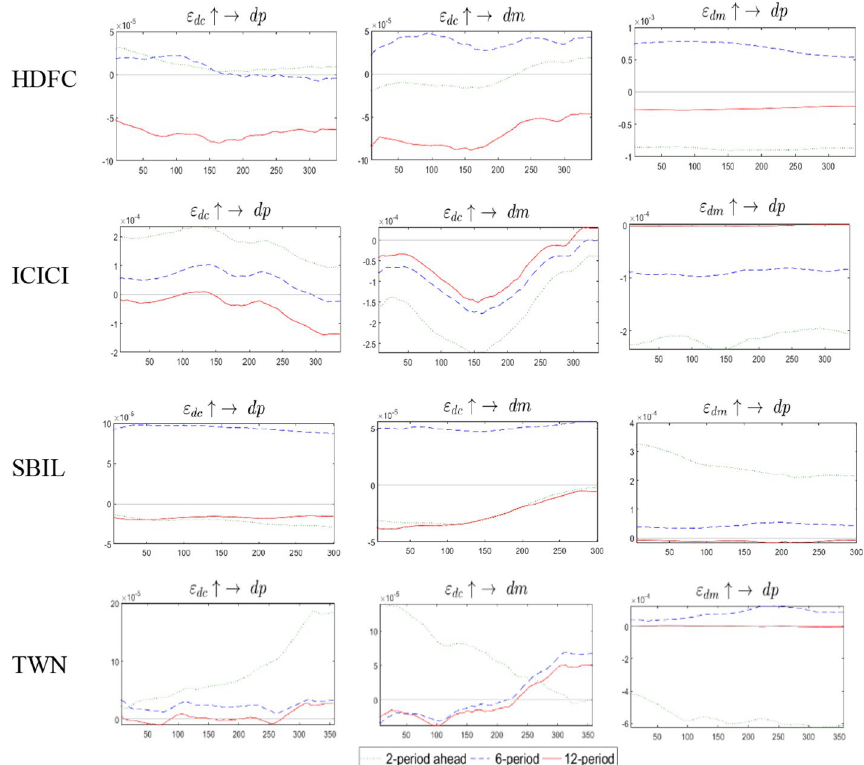
Fig. 3 The 2th‑period, 6th‑period, and 12th‑period out‑of‑forecasting impulse response analysis of TVP‑VAR model shocks